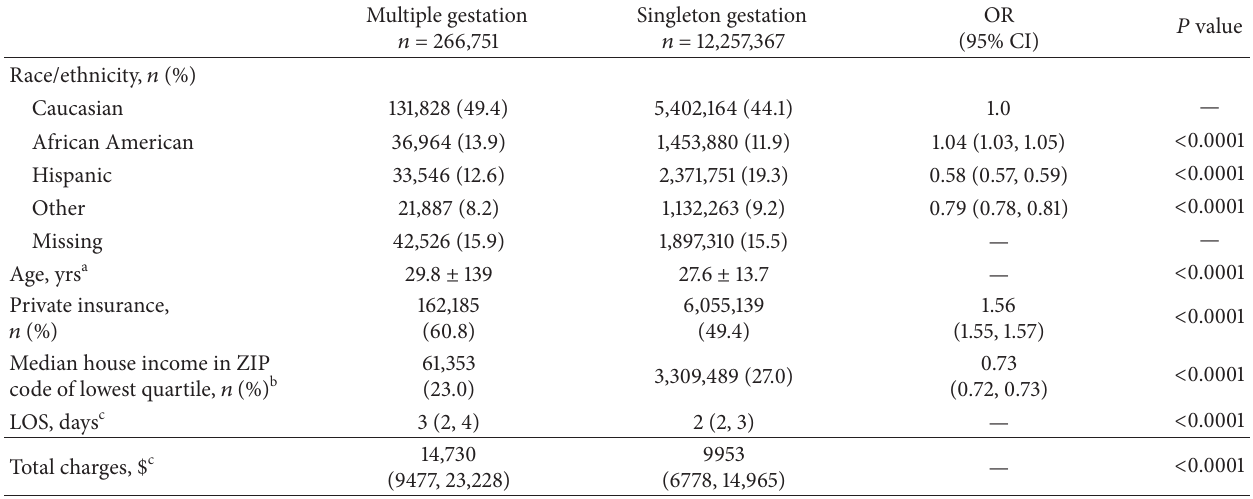
Table 1: Demographic data during hospital discharges for delivery among pregnant women with multiple gestation compared to women with singleton gestation, Nationwide Inpatient Sample for years 2008–2010 (12,524,118